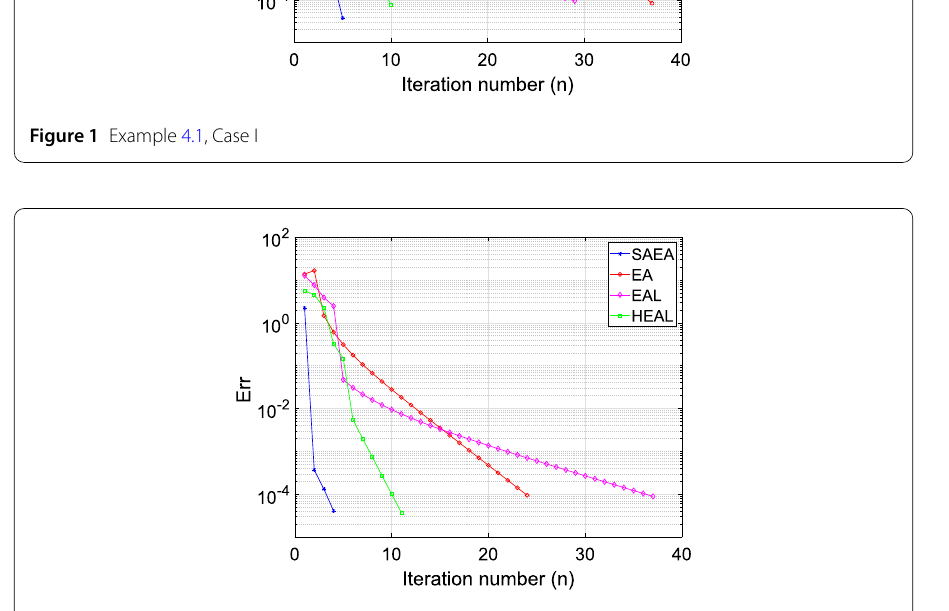
Figure 2 Example 4.1, Case